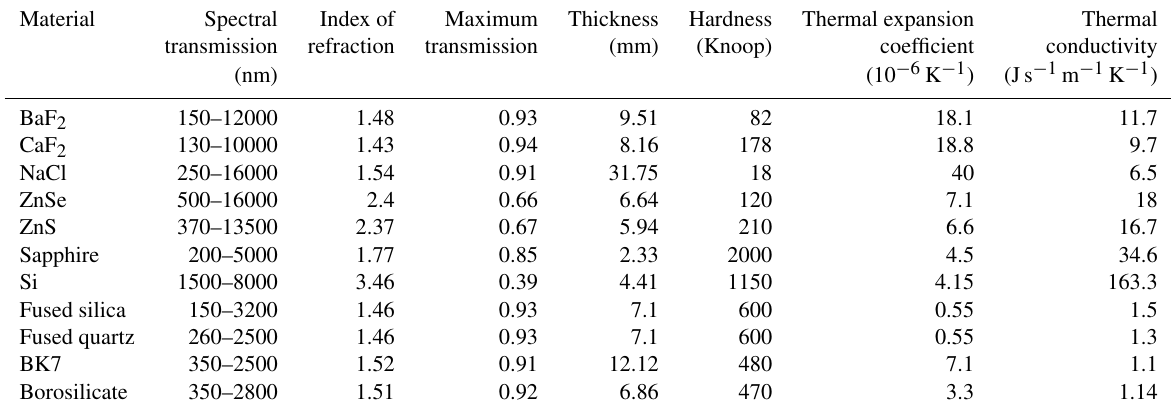
Table 2. The table lists the most important optical, thermal, and mechanical properties of a variety of optical window materials. The values reported should be taken as indicative values, since different values can be found in the literature and in specifications of commercial optical